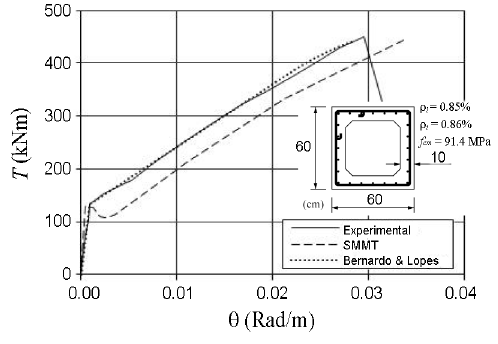
Fig. 18. T – θ curves for Beam C4